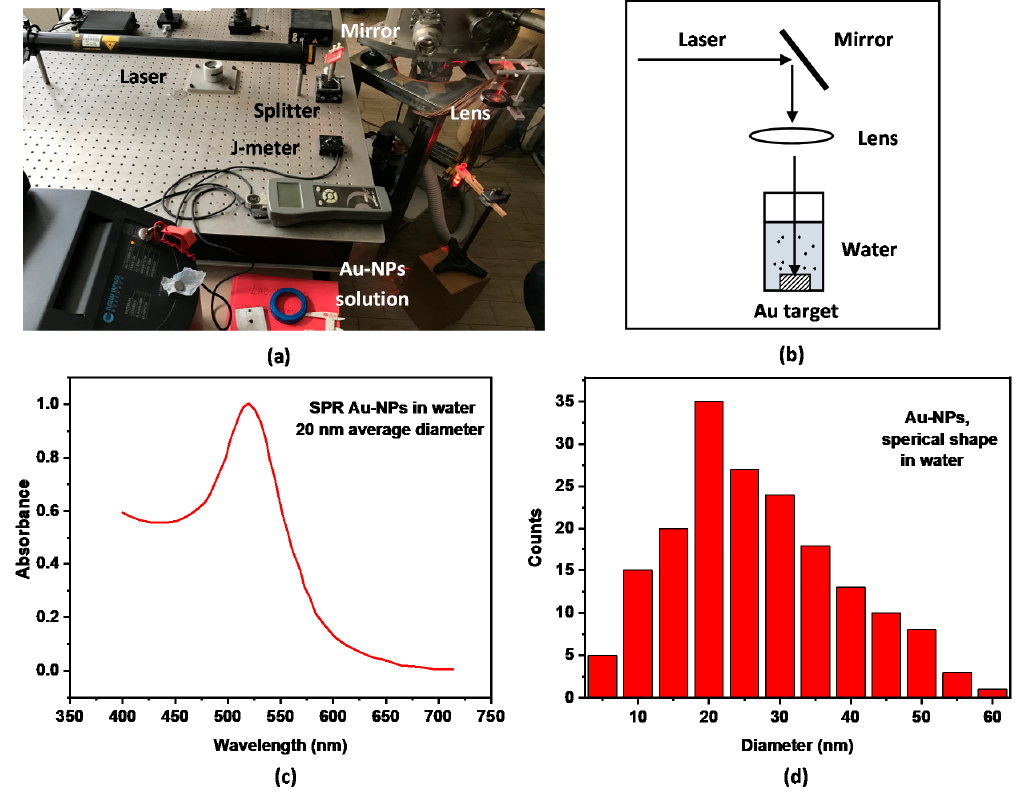
Figure 1. Experimental set-up photo ( a ), scheme of the Au NPs production by laser ( b ), measurement of absorbance vs. wavelength ( c ) and produced Au NPs diameter distribution ( d ).